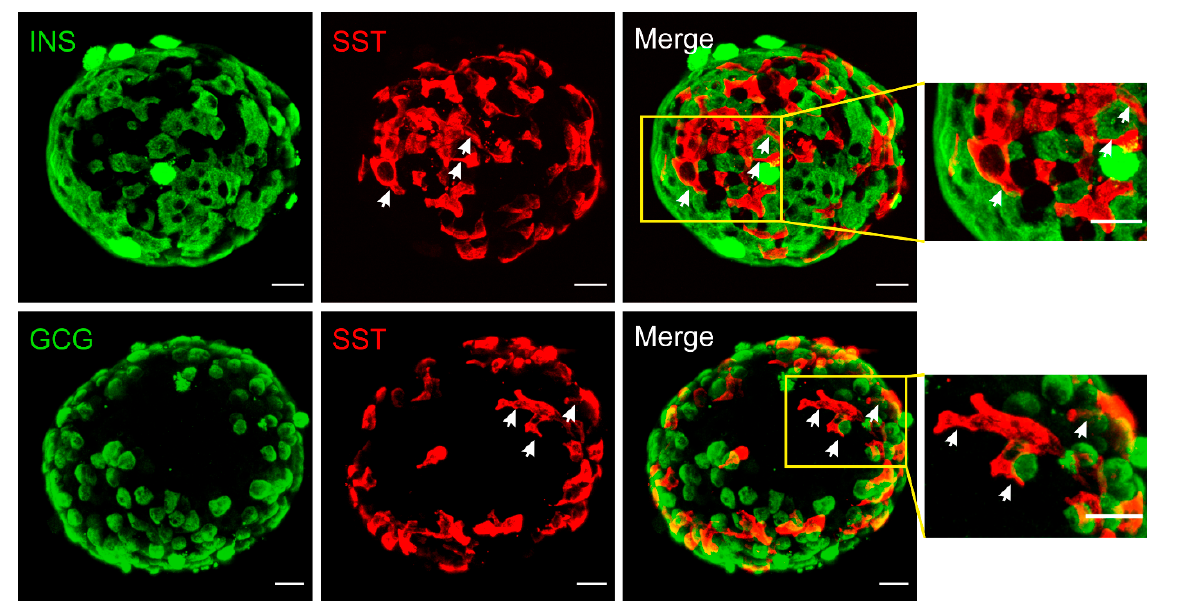
Figure 1. Immunofluorescent staining of mouse islets. Somatostatin (red), insulin (green, upper panels) or glucagon (green, lower panels). Merged panels are as indicated and areas in yellow rectangles are displayed on the right with an expanded scale. These reconstructed confocal images demonstrated the network of δ -cells and their proximity to α - and β -cells at the exterior of the islet. Note the morphology of δ -cells, which is distinctly different from α - and β -cells. The elongated projections are highlighted by arrows (white). Scale bar = 20 μ m.